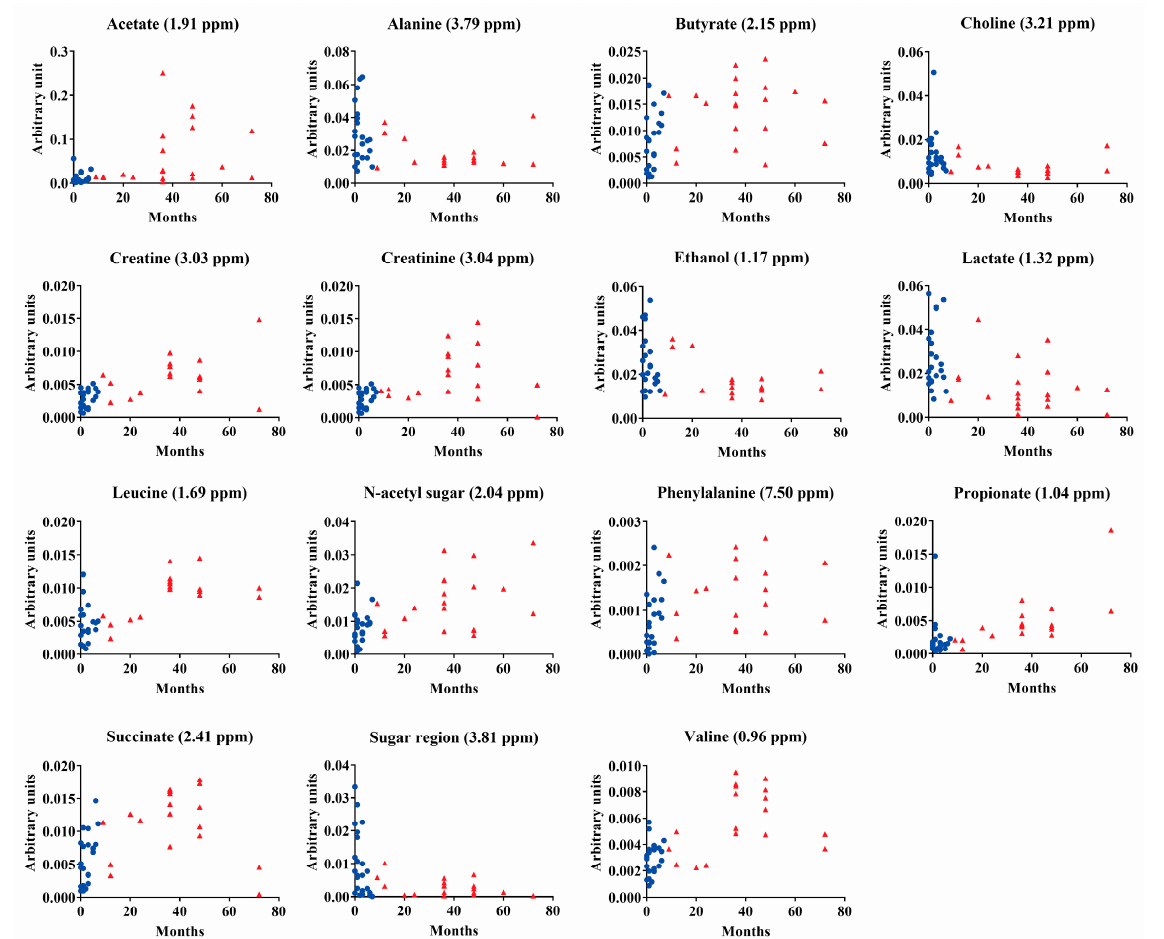
Figure 3. Normalized intensity of the peaks representing the amount of each metabolite ( y axis) in each child’s saliva, throughout the months of life ( x axis). Blue and red colors show subjects without and with teeth, respectively.